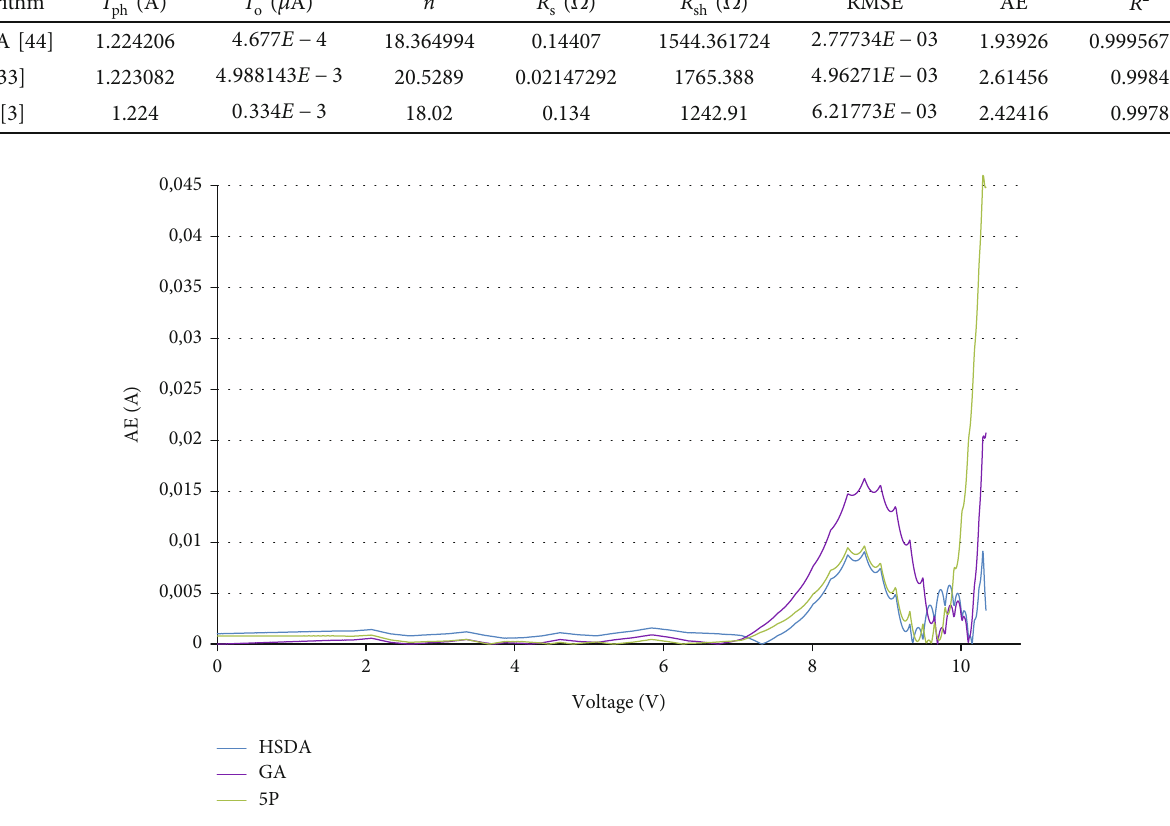
Figure 7: The absolute current error for mSi photovoltaic panel. Table 8: The statistical tests for the forecast I - V